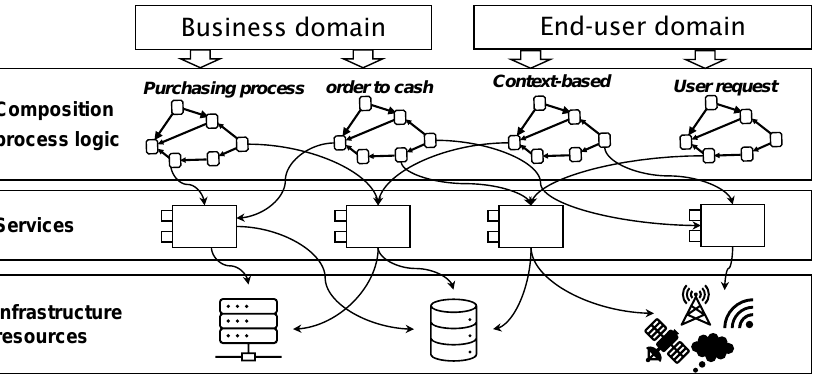
Figure 2. A layered view of SOA